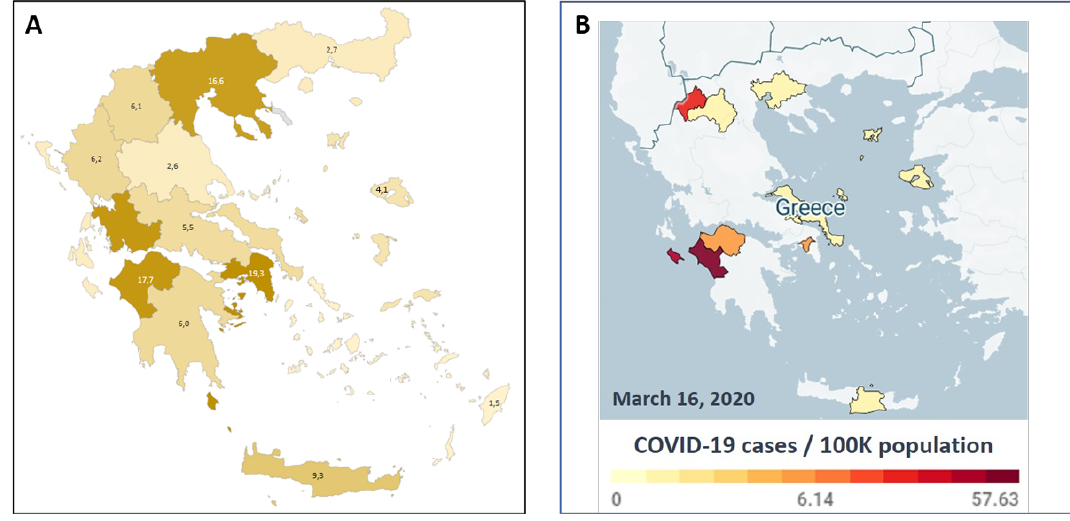
Figure S1: A: Distribution of responders (n = 1105; 16–22 March 2020) per Greek Administrative Region. Β: Distribution of COVID-19 cases per 100,000 population in Greece on 22 March 2020 (Available at: